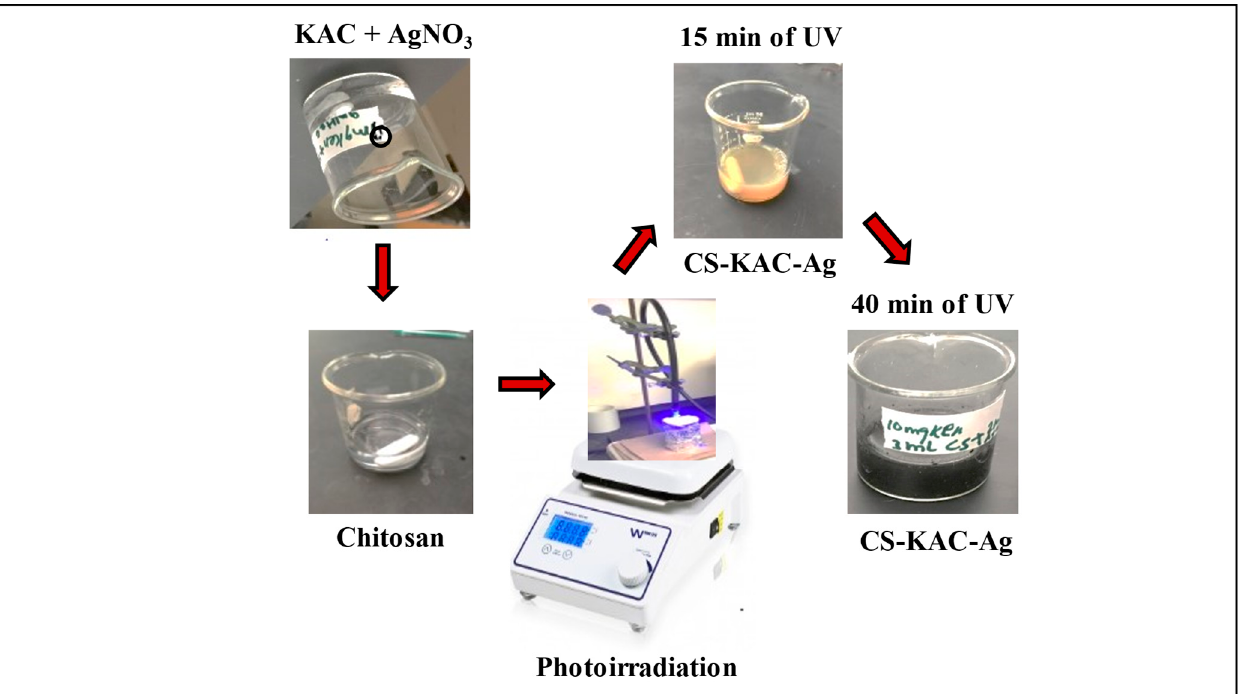
Figure 1. Schematic representation of the formation of silver nanoparticles within chitosan and kenaf ‐ based activated carbon.